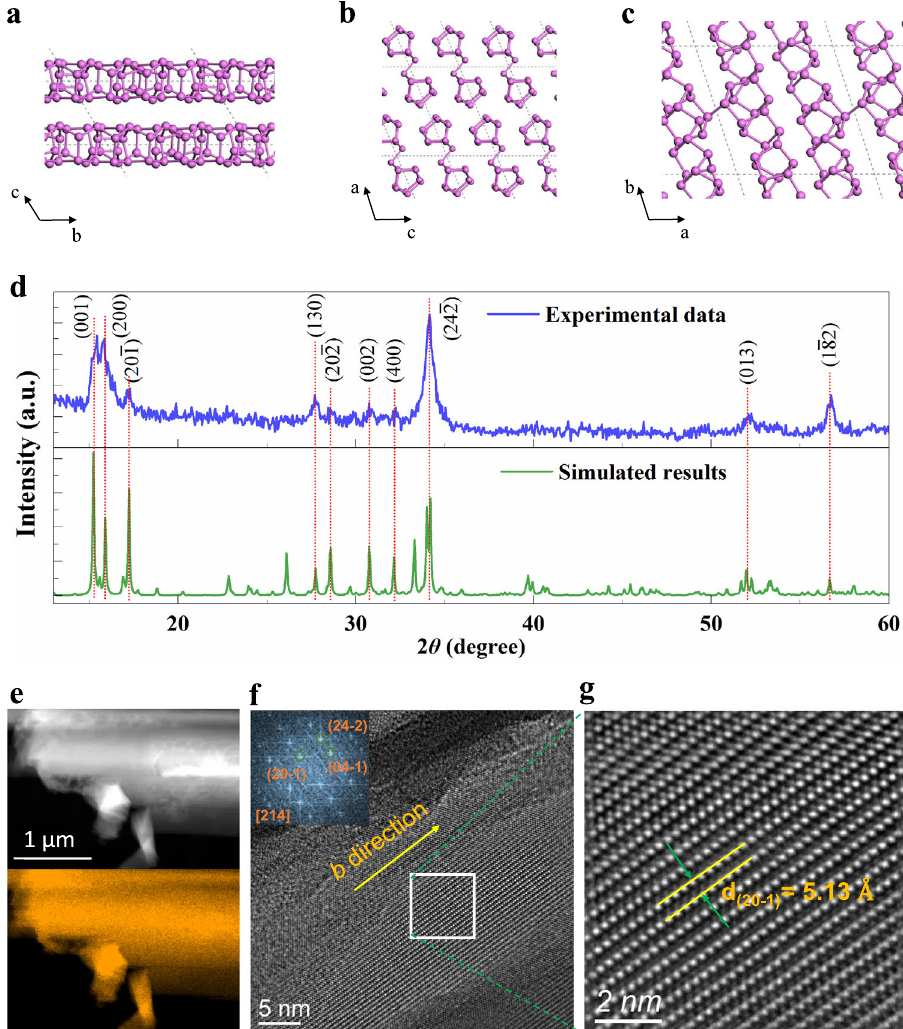
Fig. 1 Characterization of 1D vdW FRP crystal. a – c Schematic structural view of 1D vdW FRP crystal along the a ( a ), b ( b ) and c ( c ) directions. DFT- calculated lattice parameters along the a , b , and c directions are 12.37 Å, 13.11 Å, and 7.14 Å, respectively. The angles α (between b and c ), β (between a and c ), and γ (between a and b ) are ~117.07°, 106.13°, and 97.81°, respectively. d The experimentally measured XRD diffractogram (upper panel) and simulated patterns (lower pan e l). e The low-magni fi cation TEM image of 1D vdW FRP crystal (upper panel) and the corresponding EDS mapping of the phosphorus element (lower panel). f HRTEM image from the [214] zone axis, showing exclusively strands lying parallel to each other. The inset is the corresponding FFT pattern. g Enlarged HRTEM image taken from the area marked by the white outline in